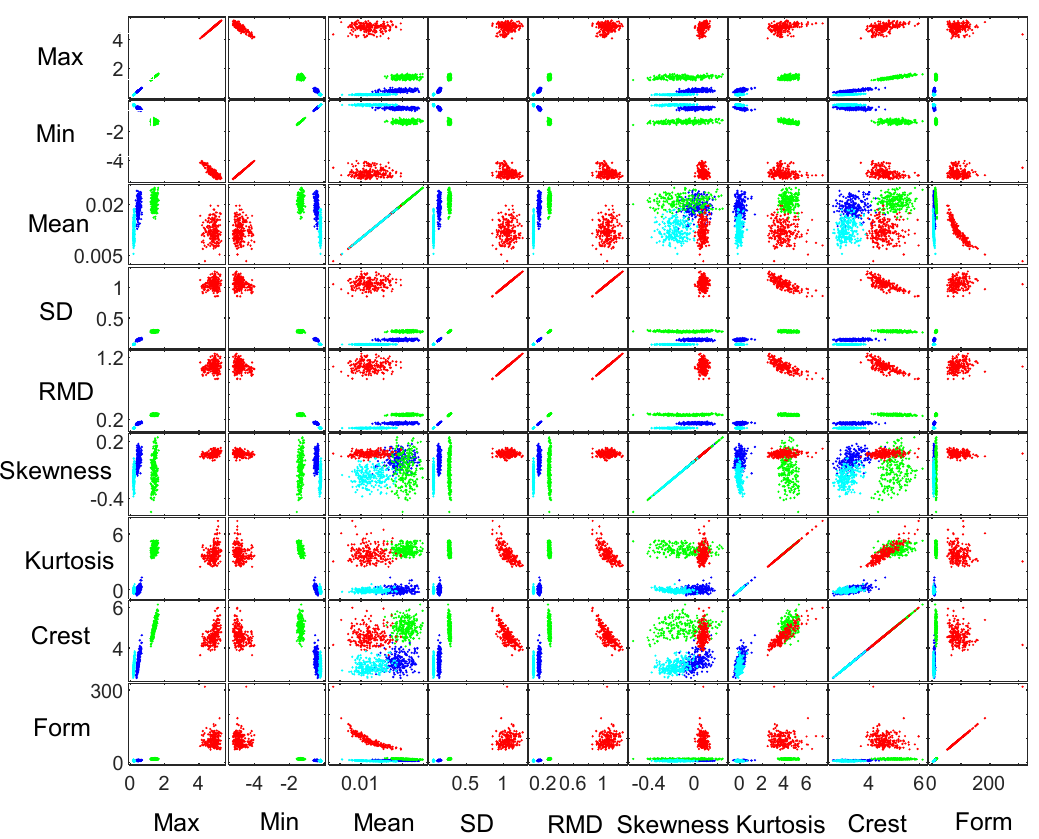
Figure 6. The plot matrix creates a sub-axis matrix of row scatter plots of nine features in the motor bearing failure ball (blue), the inner race (green), the outer race (red), and normal (light blue)